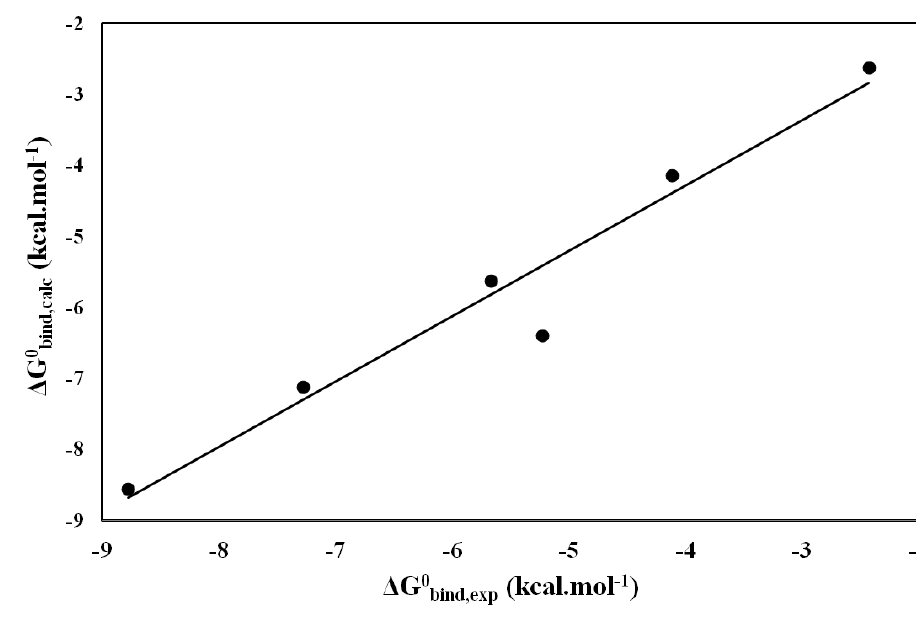
Figure 4. Linear correlation graphic between ∆G (cid:2912)(cid:2919)(cid:2924)(cid:2914),(cid:2913)(cid:2911)(cid:2922)(cid:2913)(cid:2868) and ∆G (cid:2912)(cid:2919)(cid:2924)(cid:2914),(cid:2915)(cid:2934)(cid:2926)(cid:2868) (energy values in kcal·mol − 1